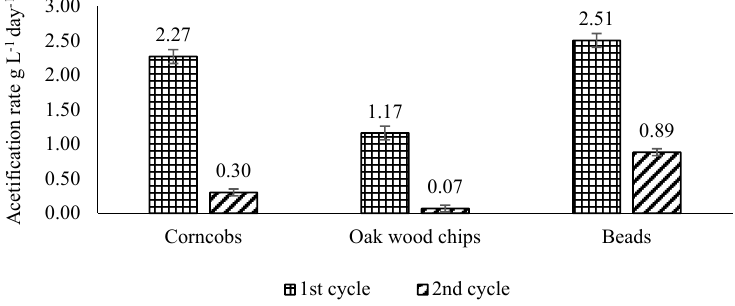
Figure 2. Acetification rates for two cycles of BSV fermentation using recycled immobilized cells.